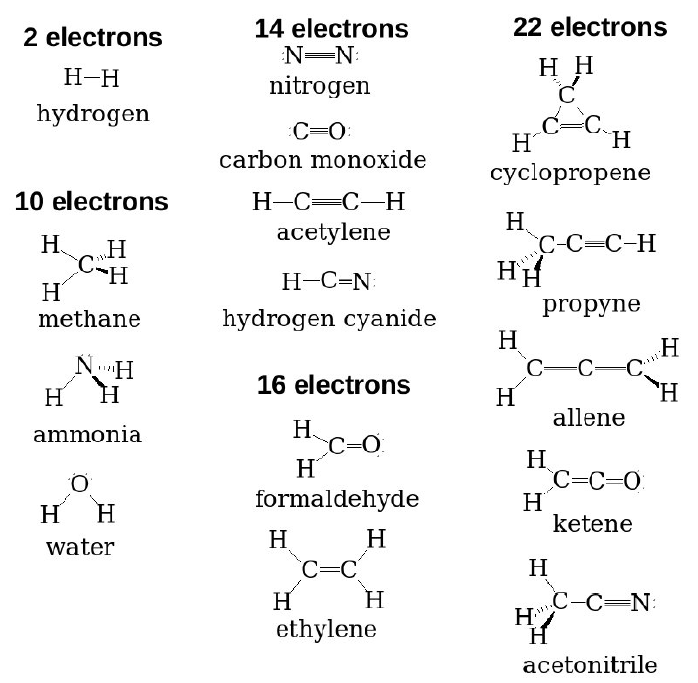
Figure 3. The 15 small molecules treated